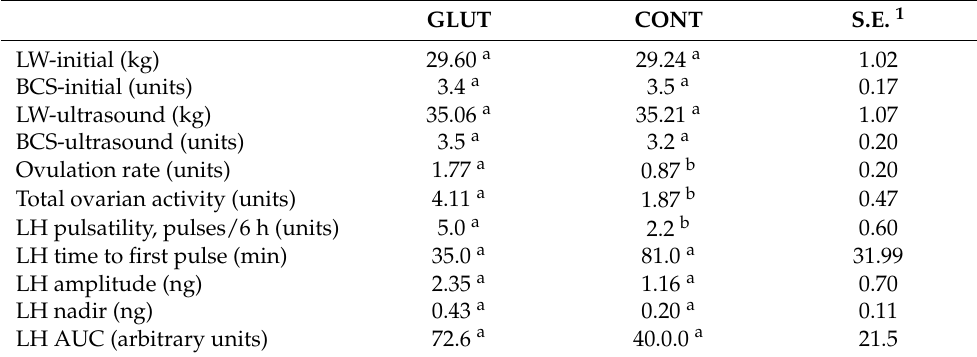
Table 1. Least-square means regarding LW and BCS at the onset of treatments (-initial) and at the ultrasound scanning (-ultrasound), ovulation rate (OR), total ovarian activity (TOA), and LH profile across time (pulsatility, time to first pulse, amplitude, nadir and AUC) in goats supplemented with glutamate (GLUT) and non-supplemented (CONT)